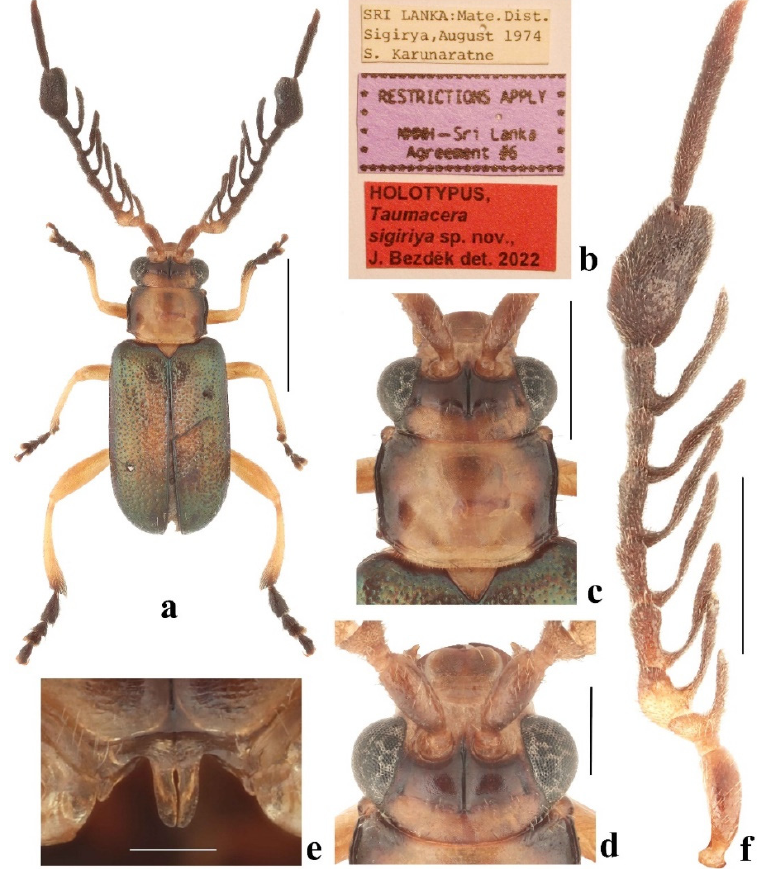
Figure 16. Taumacera sigiriya sp. nov., holotype: ( a ) holotype, male; ( b ) labels; ( c ) head and pronotum, dorsal view; ( d ) head, frontal view; ( e ) metasternal process; ( f ) left antenna. (Scale bars: ( a ) = 2 mm, ( c , f ) = 1 mm, ( d ) = 0.5 mm, ( e ) = 0.3 mm, ( b ) not to scale).